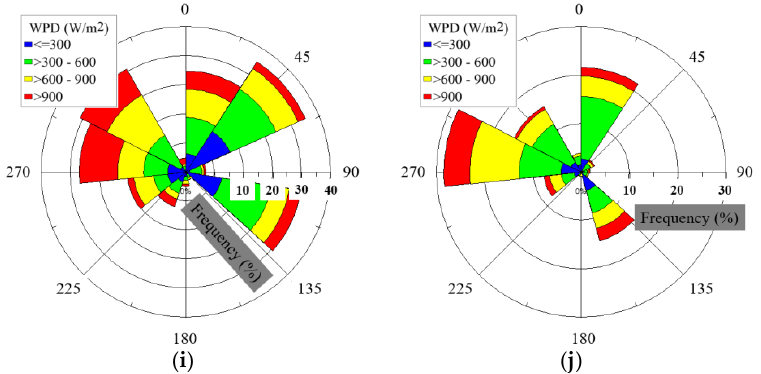
Figure 5. Wind roses of newly proposed wind farm sites at 10 m height ( a ) Site 1; ( b ) Site 2; ( c ) Site 3; ( d ) Site 4; ( e ) Site 5; ( f ) Site 6; ( g ) Site 7; ( h ) Site 8; ( i ) Site 9; ( j ) Site 10.